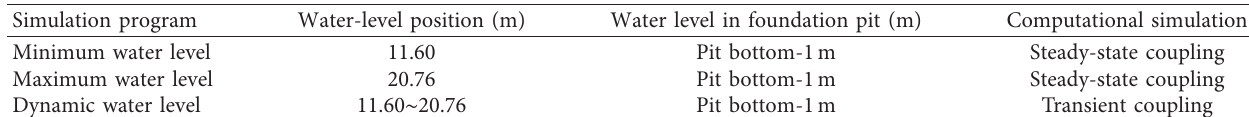
Figure 4: Change trend of water level of the cofferdam: (a) actual water-level change; (b) simplified water lever based on interpolation. Table 2: Simulation